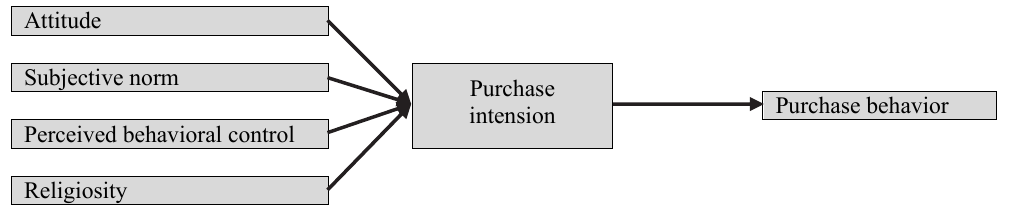
Fig. 1. Conceptual Framework of the Current